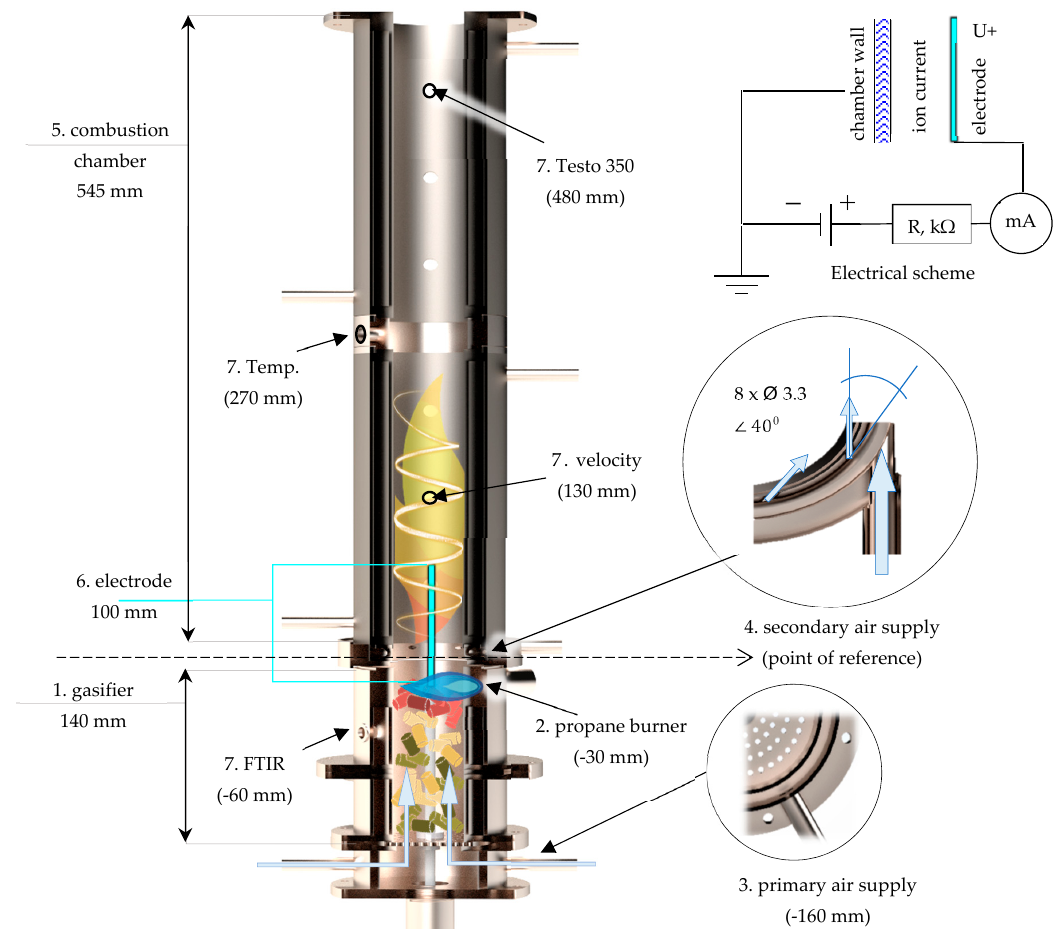
Figure 1. The batch-size pilot setup for experimental studies: 1—gasifier filled with a mixture of biomass pellets; 2—propane flame inlet nozzle; 3—primary air supply at the bottom of the gasifier; 4—secondary swirling air inlet at the combustor bottom; 5—water-cooled sections of the combustion chamber; 6—axially inserted central electrode; 7—openings the diagnostic tools. The technological scheme of main equipment and measurement instruments is available at Figure